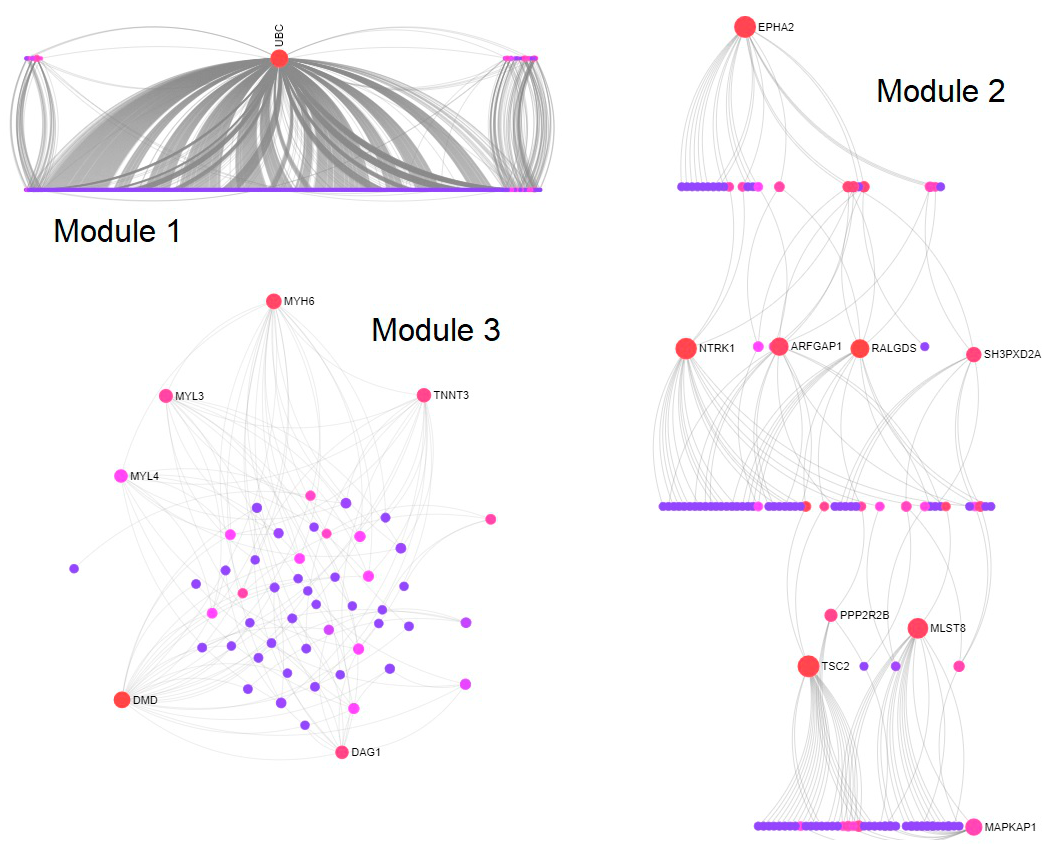
Figure 4. Walktrap modules of potential target genes extracted from the PPI network. Sugiyama layout of Module 1 (33 nodes; p = 1.98 × 10 − 74 ); linear bipartite / tripartite layout of Module 2 (15 nodes; p = 1.21 × 10 − 08 ); circular bipartite / tripartite layout of Module 3 (10 nodes; p = 1.62 × 10 − 14 ). Red color indicates downregulated, pink color indicates upregulated genes, and blue color indicates interconnected genes. Change in the size of the nodes depends on degree centrality measures. Table 3. Degree and betweenness centrality measures of 12 di ff erent potential target genes (PTGs). O ffi cial